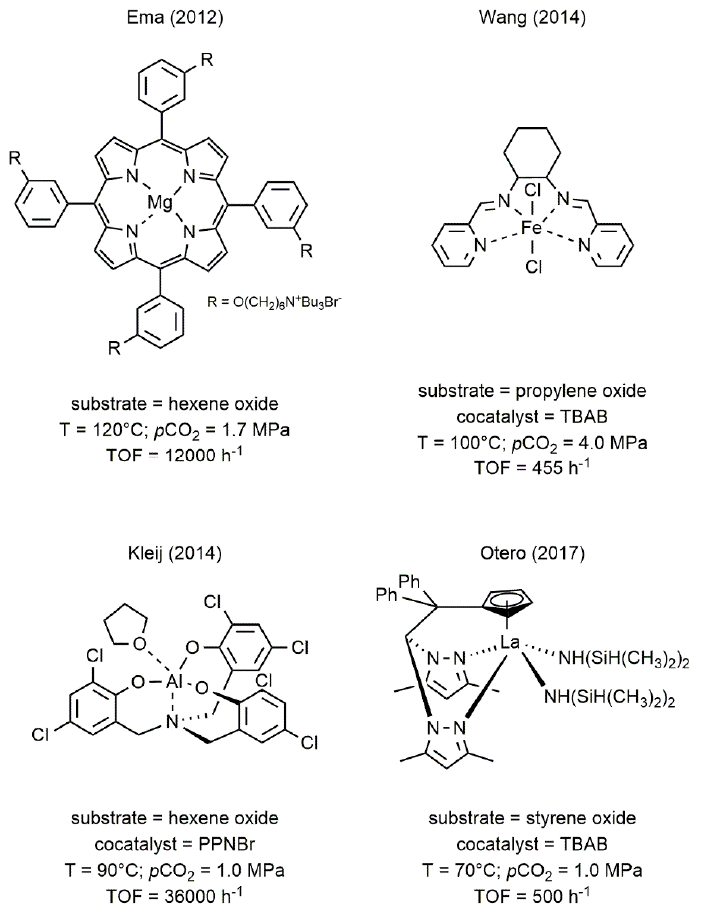
Figure 1. Selected catalytic systems for the synthesis of cyclic organic carbonates (COC) from CO 2 and epoxides [22,25,29,30].